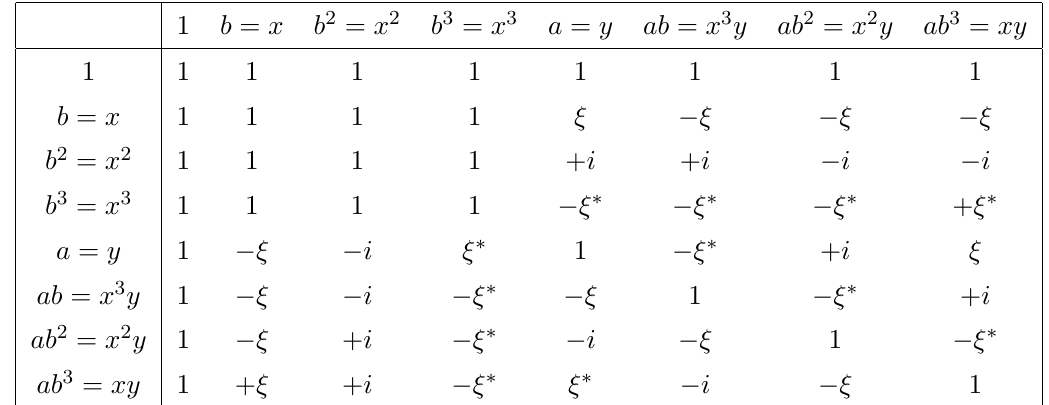
Table 2 . Cocycle π ∗ ω for ω the nontrivial element of D 4 discrete torsion and π : Z 4 o Z 4 → D 4 . We define ξ = exp(+6 πi/ 8) , matching the ξ of table